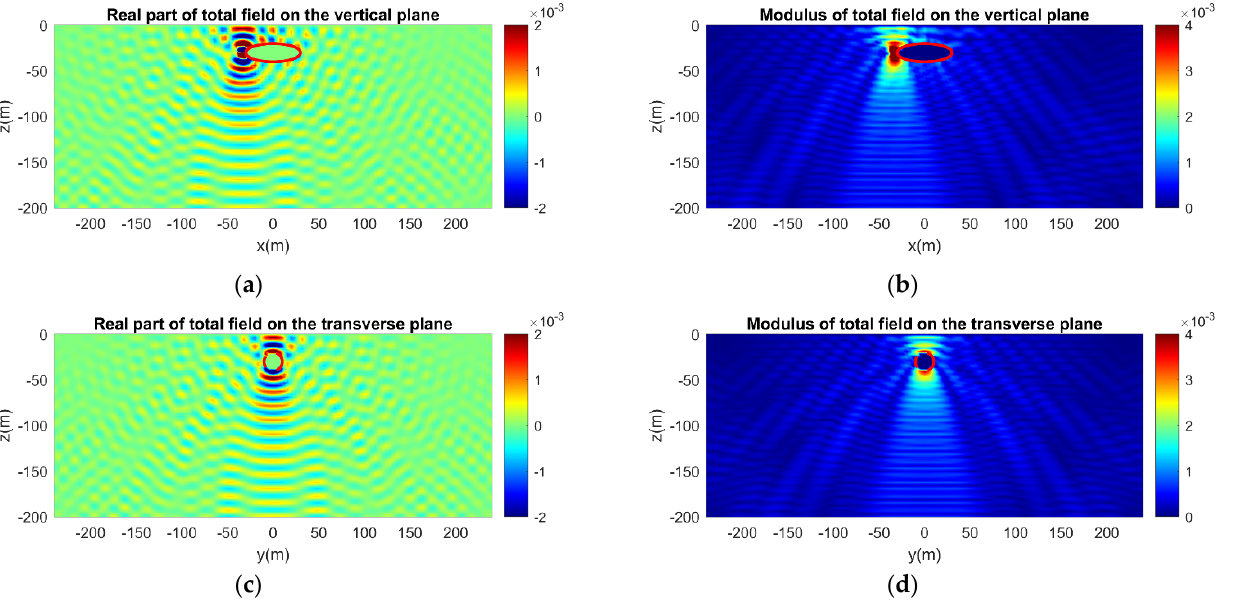
Figure 16. Same as in Figure 14, but for a vertical dipole source. The axis of the dipole is parallel to